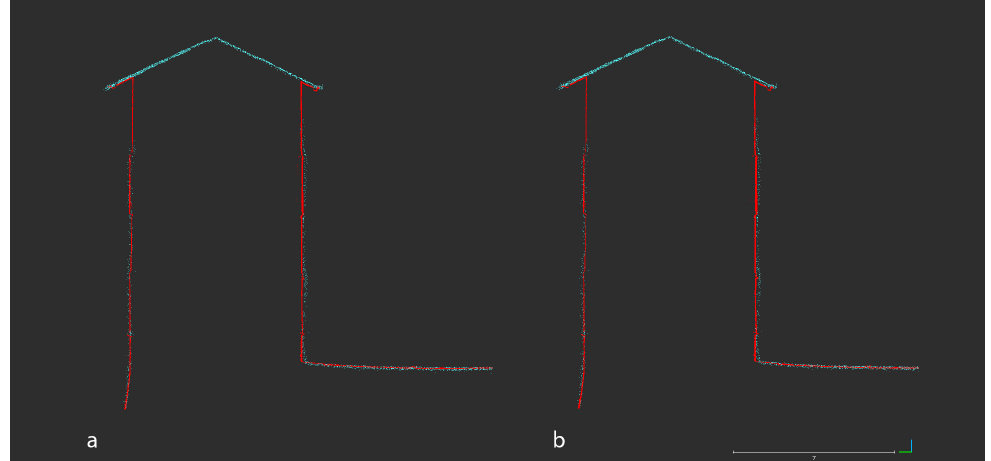
Figure 23. Detail on Profile 2 ICP alignment. L1 (cyan) aligned with SX10 data (red): ( a ) before the alignment; ( b ) after the alignment.